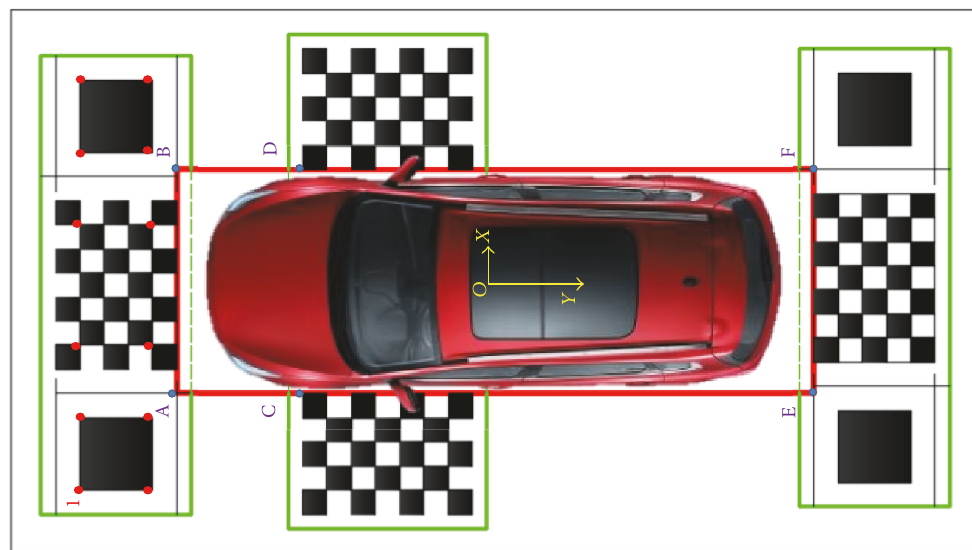
Figure 2: The illustration of calibration